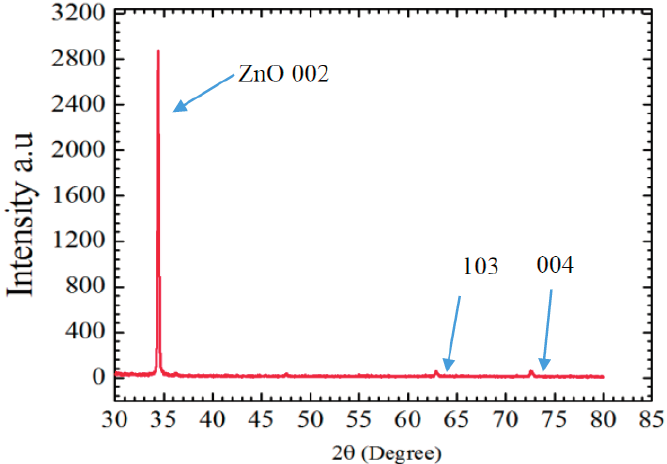
Figure 4. XRD pattern of ZnO nanorods after annealing at 150